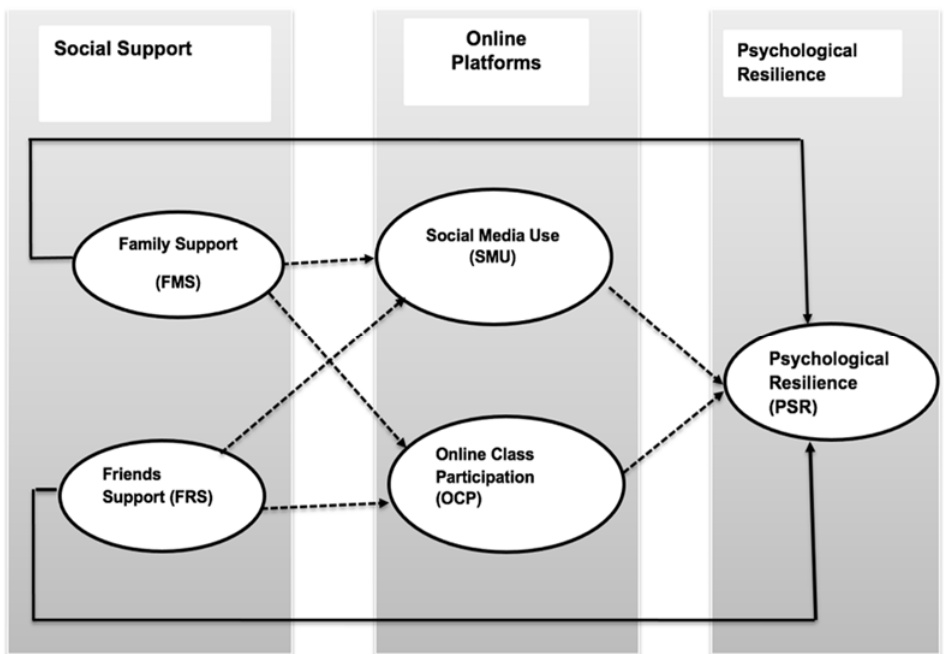
Figure 1. Conceptual framework.